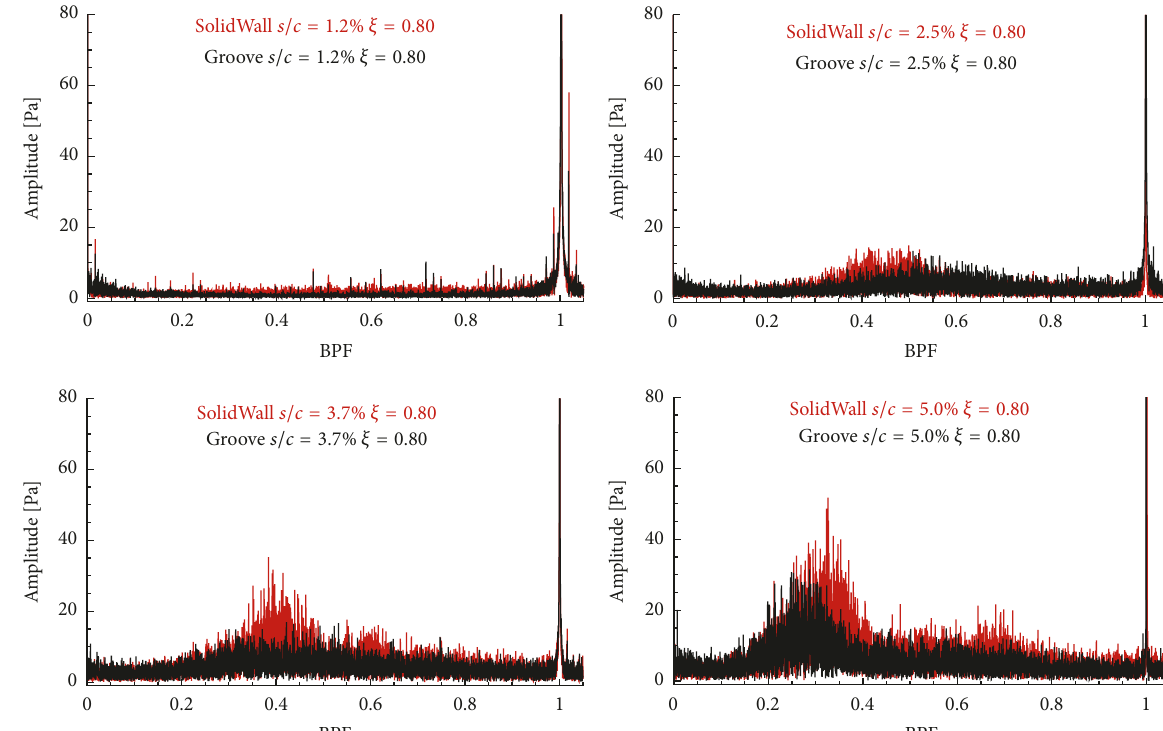
≈ 0.125 for SolidWall and Groove at the throttled operating point for 𝑠/𝑐 = 1.2%, ax